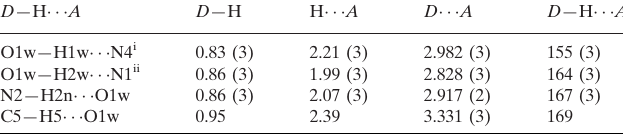
Hydrogen-bond geometry (A˚ , (cid:3)